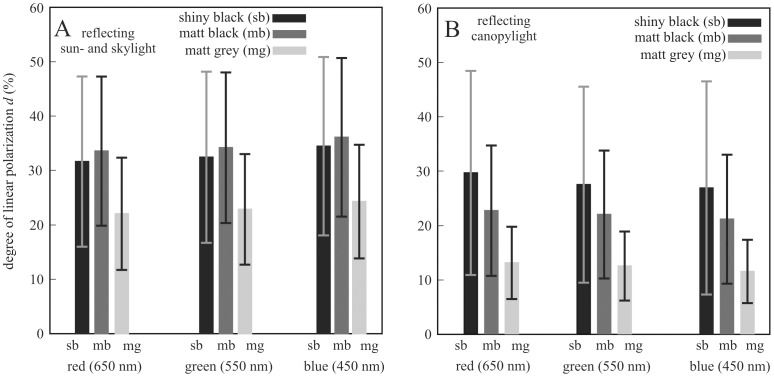
Degree of linear polarization d of the shiny black (sb), matt black (mb) and matt grey (mg) horizontal test surfaces used in experiments 1 and 2 measured with imaging polarimetry in the red (650 nm), green (550 nm) and blue (450 nm) parts of the spectrum when sun- and skylight (A, Supplementary Fig. S4I) or canopylight originating from trees and bushes (B, Supplementary Fig. S4II) was reflected by the test surfaces.Columns: averages. Vertical bars: standard deviations. The average is calculated for the whole area of each test surface (corresponding to 2500×4000 = 10 000 000 pixels in the pictures and polarization patterns).